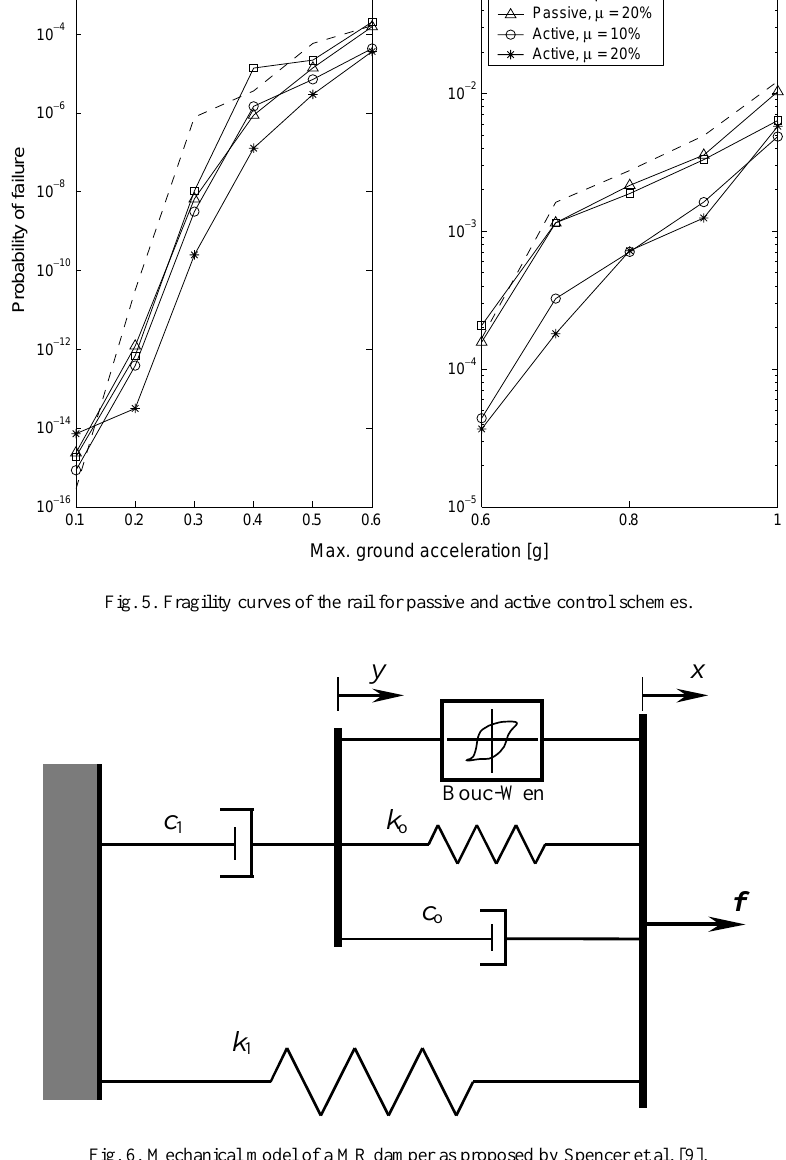
Fig. 6. Mechanical model of a MR damper as proposed by Spencer et al.